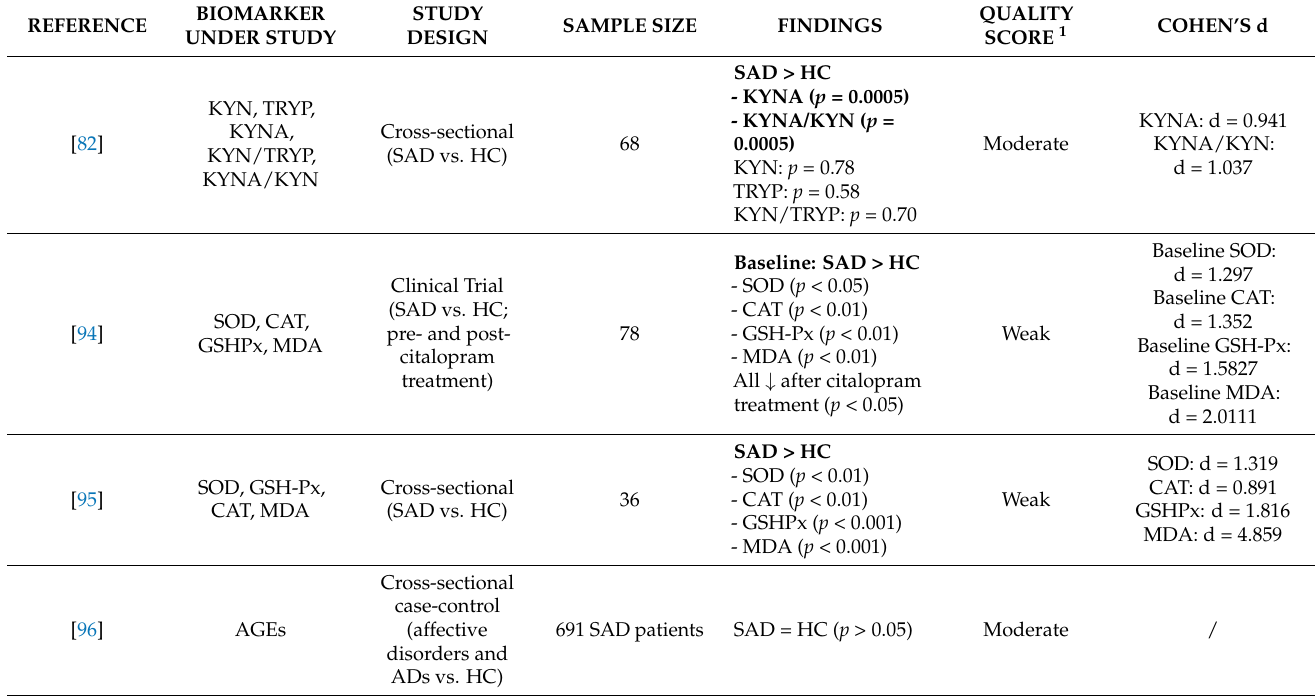
Table 4. Summary of findings regarding antioxidant system biomarkers of